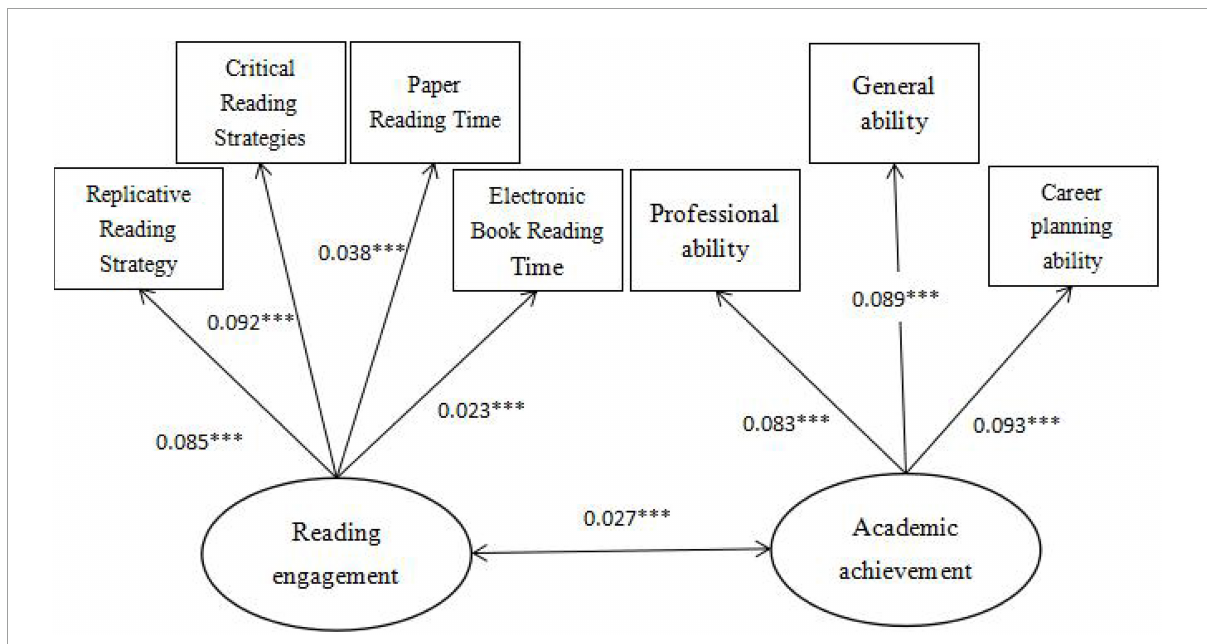
FIGURE3 Structural equation model of college students’ reading engagement and academic achievement (after normalization). Significance level * P < 0.1, ** P < 0.05, and *** P <